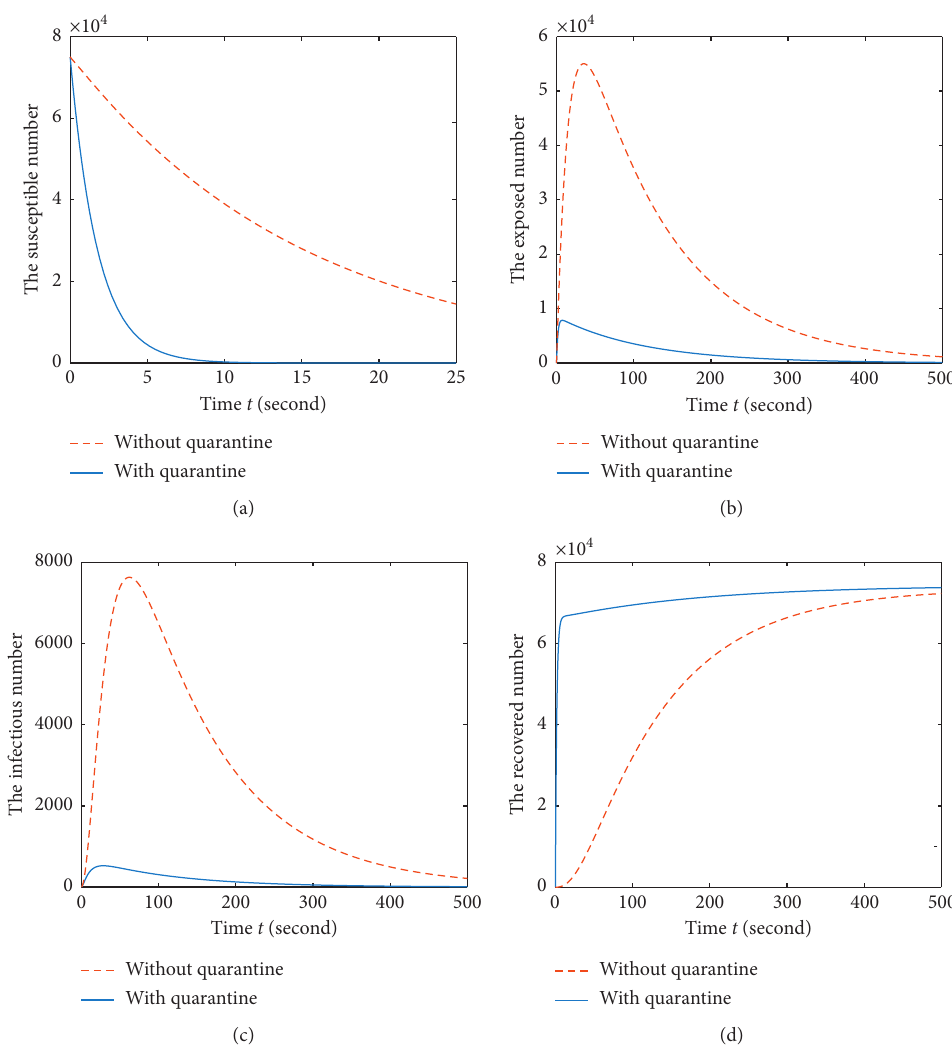
Figure 5: Dynamics of system without/without